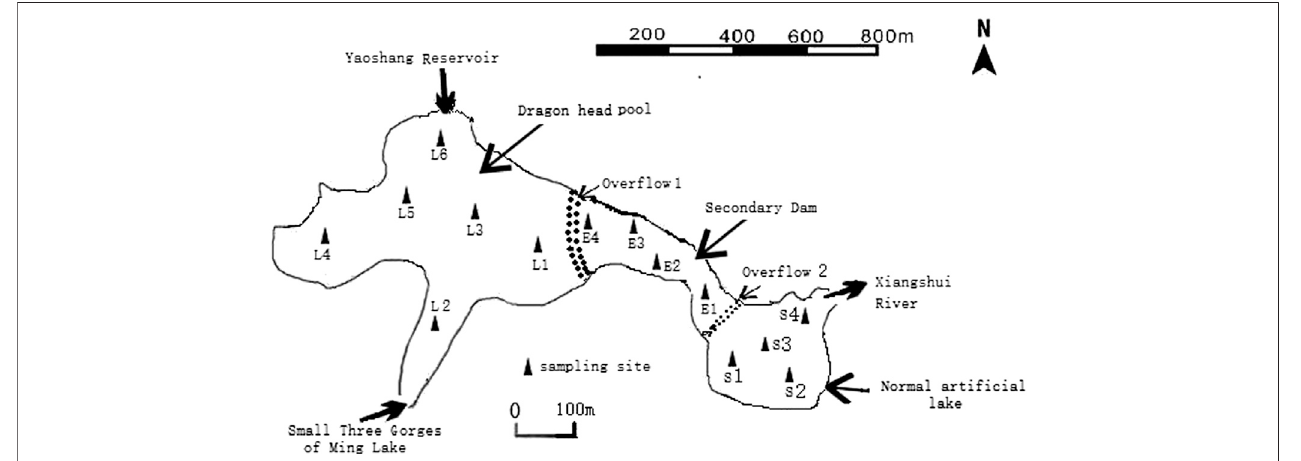
FIGURE 1 | Layout of sampling points in Minghu Wetland.